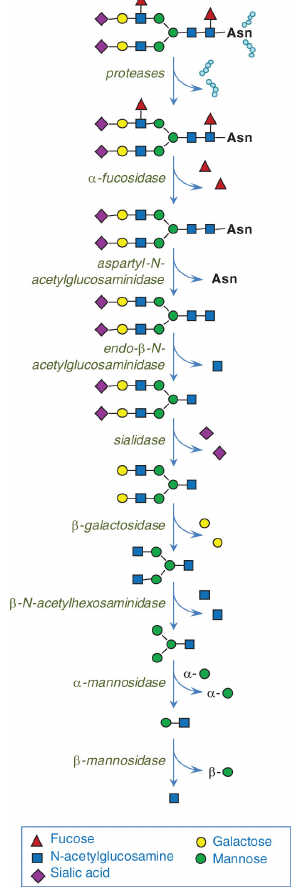
Figure 1: Catabolic pathway of N-linked oligosaccharides.